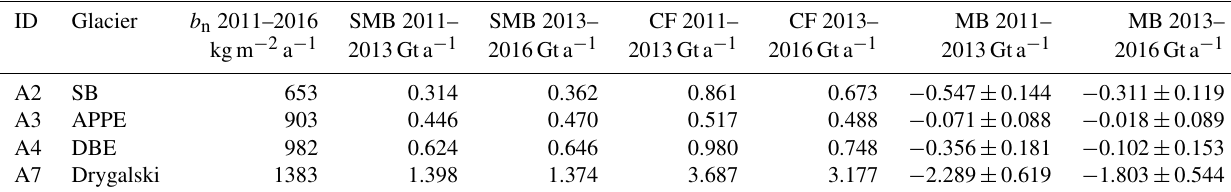
Figure 4. Magnitude of ice velocity (md − 1 ) 2011 (a) and 2016 (b) derived from TerraSAR-X and TanDEM-X data. Gaps in 2011 filled with PALSAR data and in 2016 filled with Sentinel-1 data. (c) Map of velocity difference between 2016 and 1995 (October–November). Insets: velocity difference between 2016 and 2011 for Sjögren, DBE and Drygalski glaciers. Table 3. Mean specific surface mass balance, b n , for 2011 to 2016, and rates of surface mass balance (SMB), calving flux (CF) and mass balance (MB) using the mass budget method in Gta − 1 for the periods 2011 to 2013 and 2013 to 2016 for outlet glaciers north of Seal